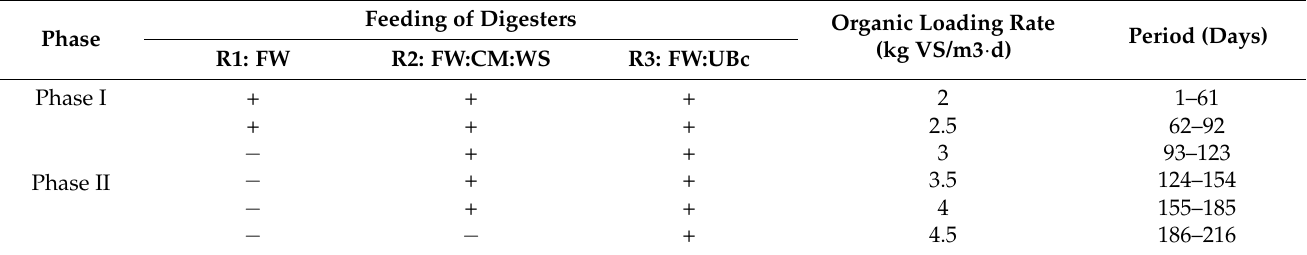
Table 1. Experimental setup